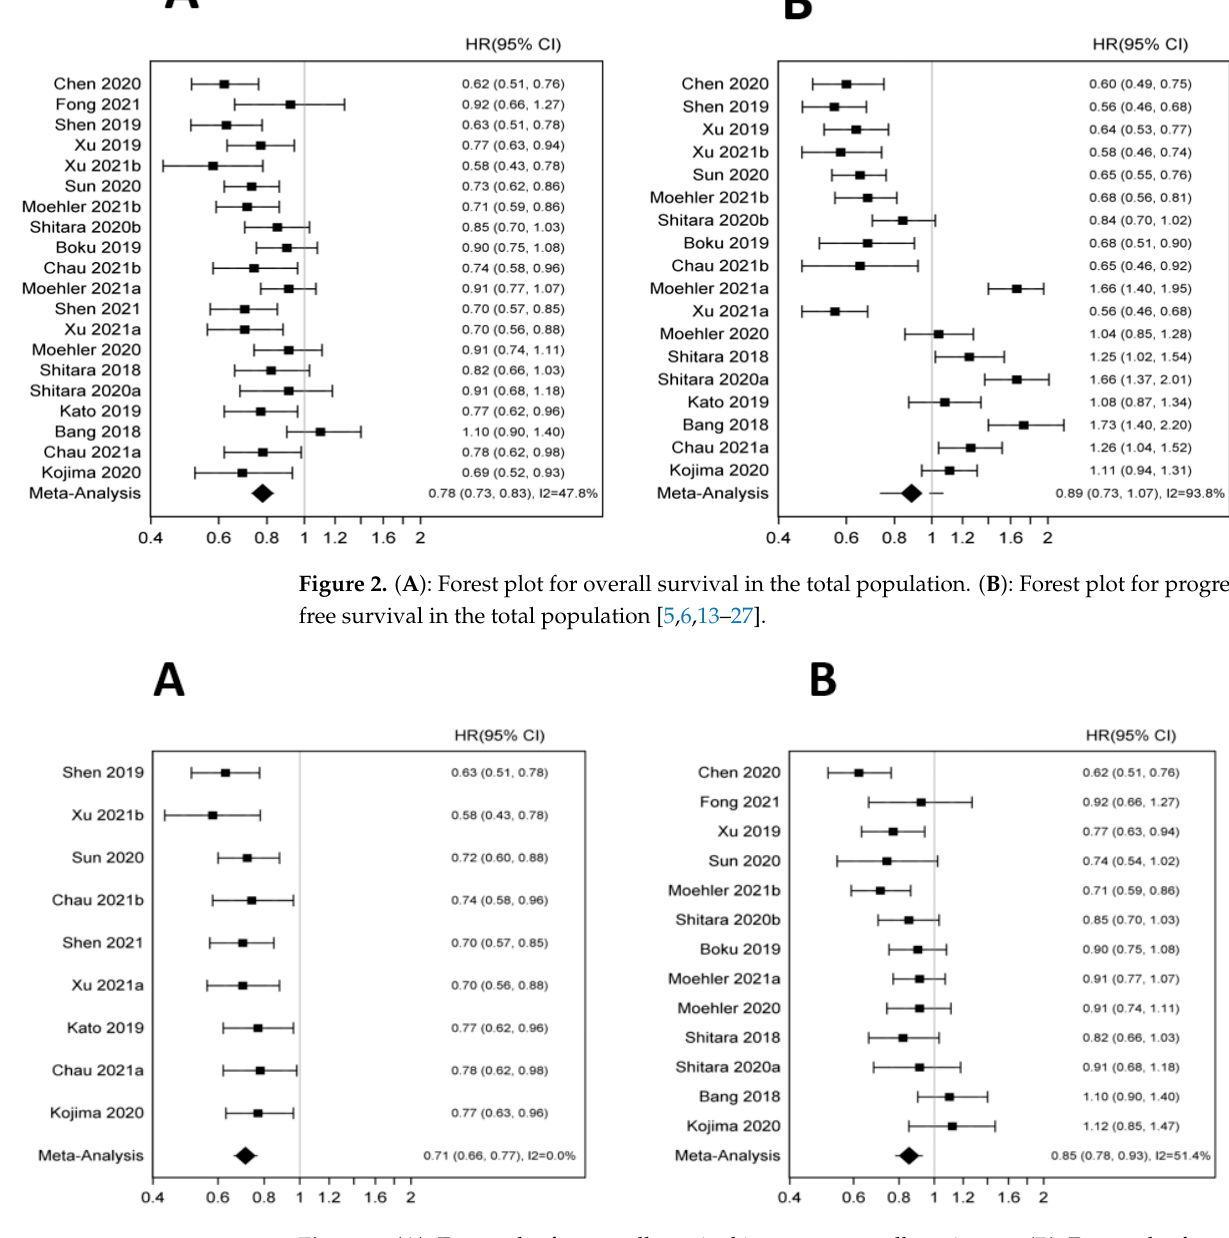
Figure 3. ( A ): Forest plot for overall survival in squamous cell carcinoma. ( B ): Forest plot for overall survival in adenocarcinoma [5,6,13–27].